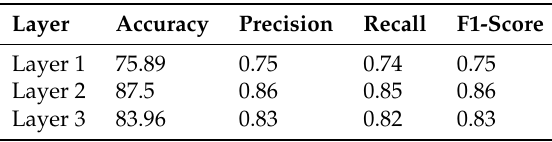
Table 10. LSTM Results—MIT-BIH Atrial Fibrillation.